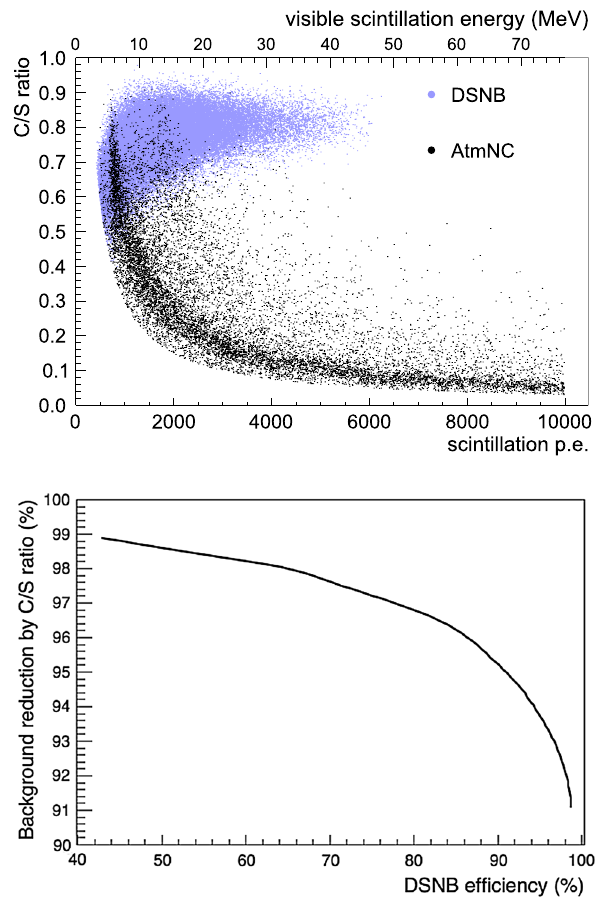
Fig. 15 Top panel: The C/S ratio offers a powerful tool for the dis- crimination of positron-like DSNB (blue) and hadronic prompt events from atm-NC reactions (black). While most background events feature no Cherenkov light and, as such, a C/S ratio of 0, some final-state γ rays result in a curved band of atm-NC events that leaks slightly into the signal region. Bottom panel: atm-NC background reduction as function of the DSNB signal efficiency